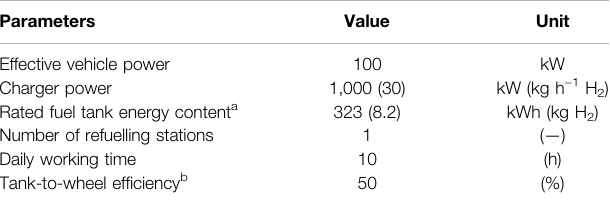
TABLE 3 | Inputs used for simulation of H 2 demand of the fuel cell agricultural machinery (FCAM). Parameters